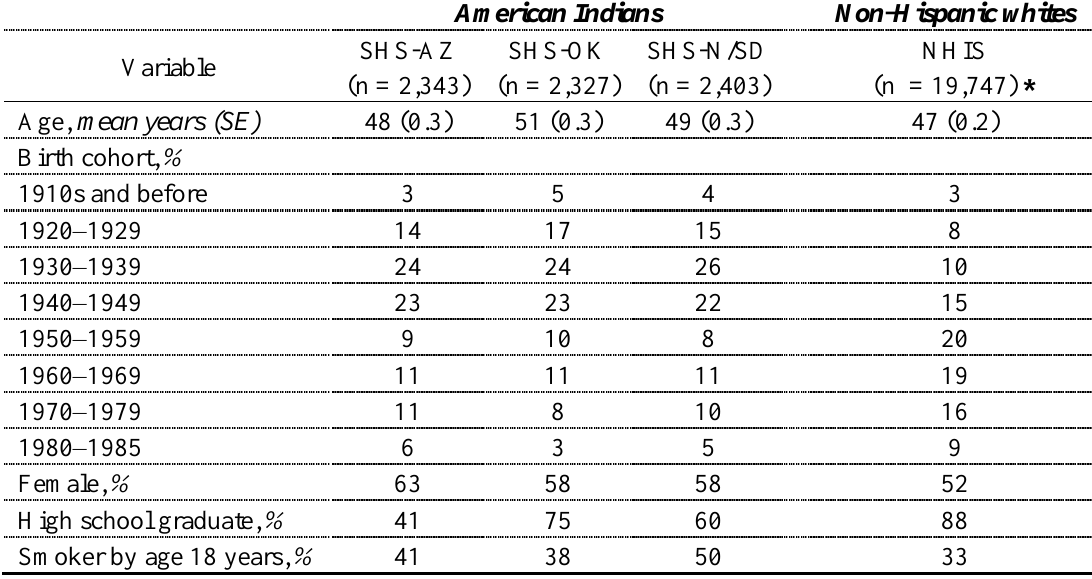
Table 1. Participant characteristics from the Strong Heart Study (SHS) and the 2003 National Health Interview Survey